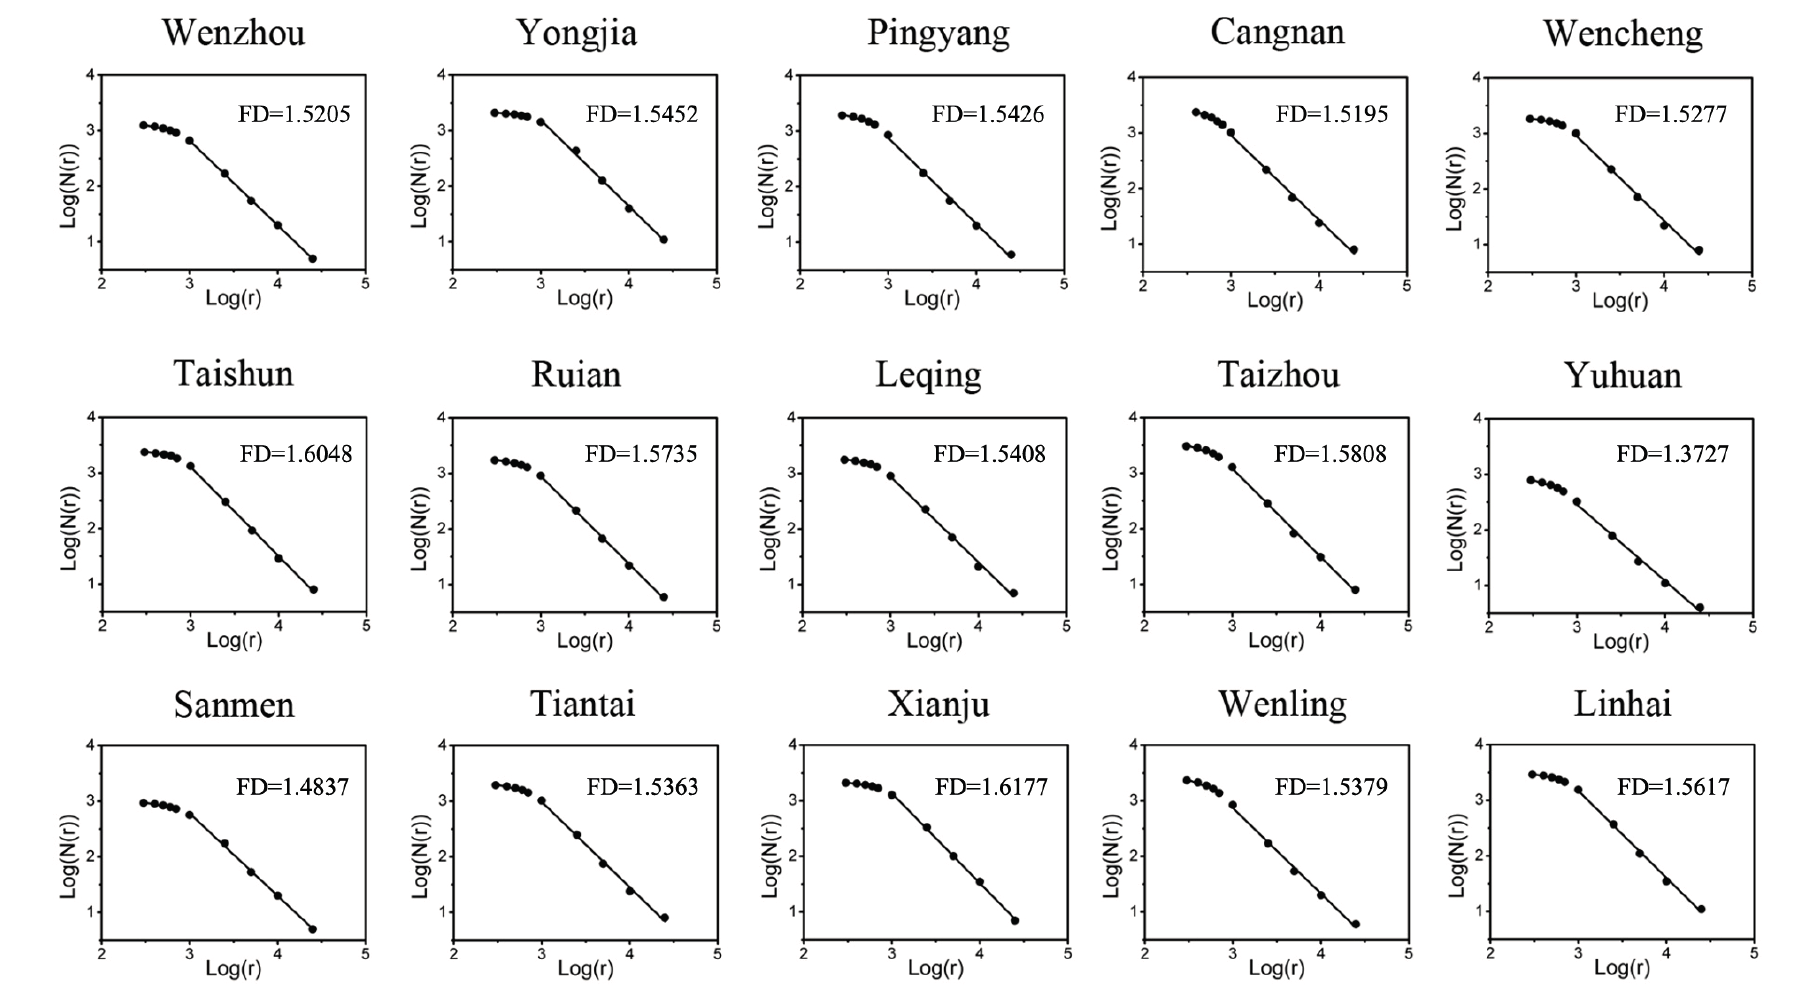
Figure 3. Graphs of number of boxes N(r) against box side length (in meters) on logarithmic scales for each city across the Wen-Tai region, China. (FD = Fractal Dimension